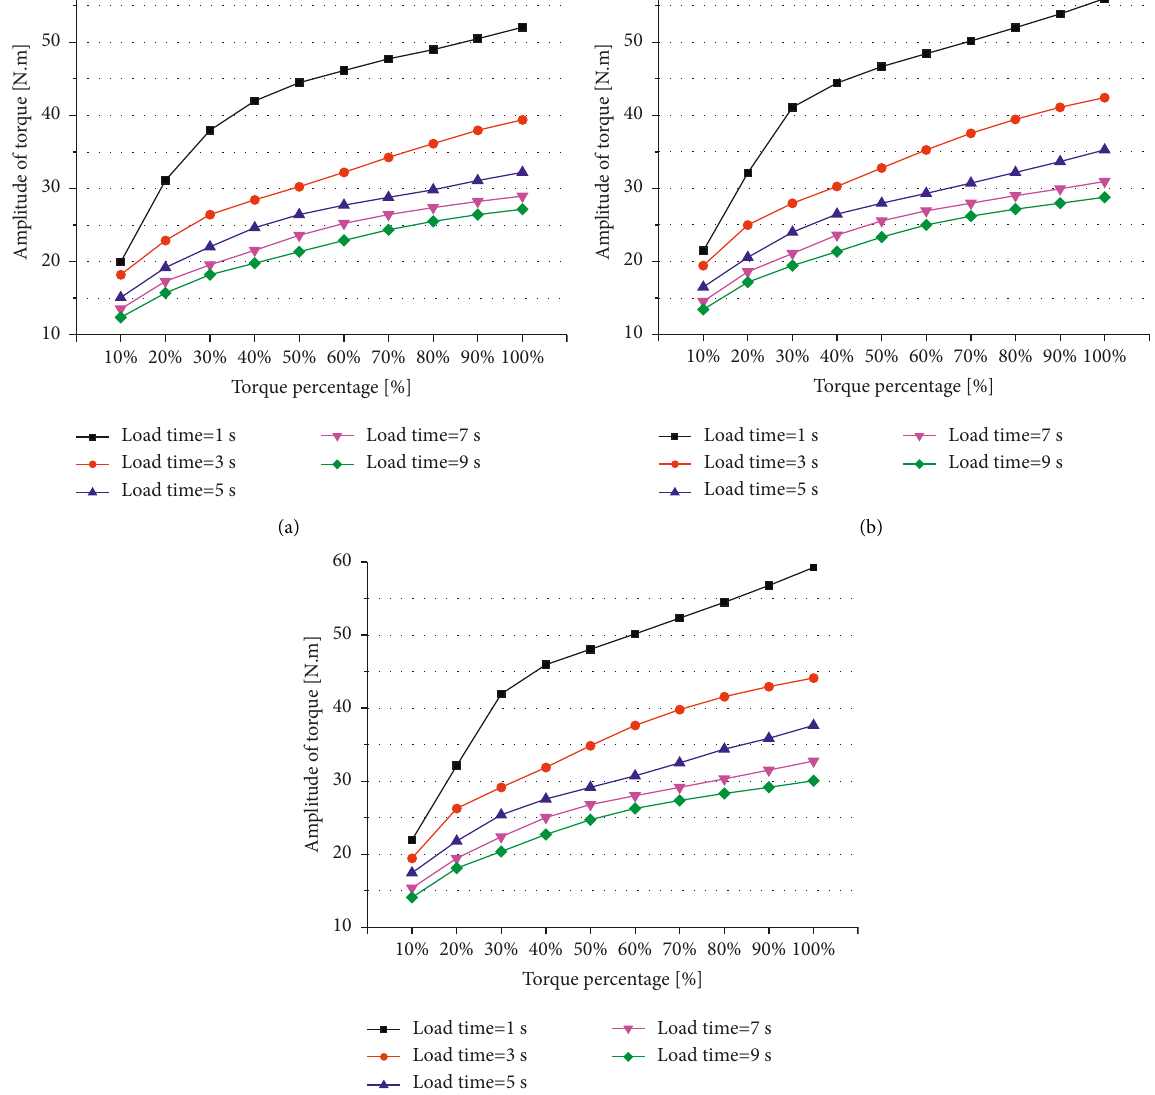
� 50%, (b) N � 70%, and (c) N � R R R